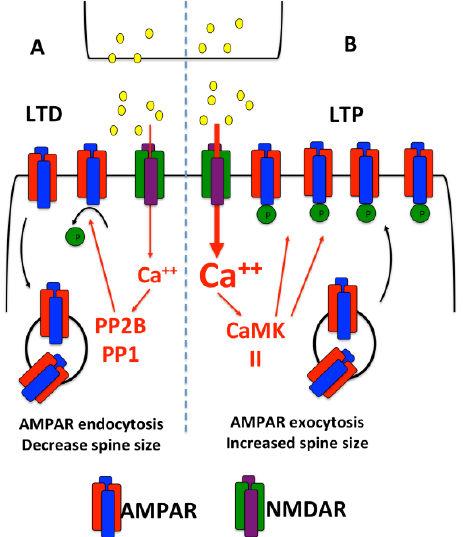
Figure 1. Long-Term Depression (LTD) and Long-Term Potentiation (LTP). ( A ) LTD occurs when a low rise in post-synaptic [Ca ++ ] activates phosphatases that dephosphorylate AMPARs to reduce their sensitivity and promote their endocytosis; ( B ) LTP occurs when a larger rise in post-synaptic [Ca ++ ] activates CaMKII, promotes AMPAR phosphorylation, and AMPAR insertion into the post-synaptic membrane.